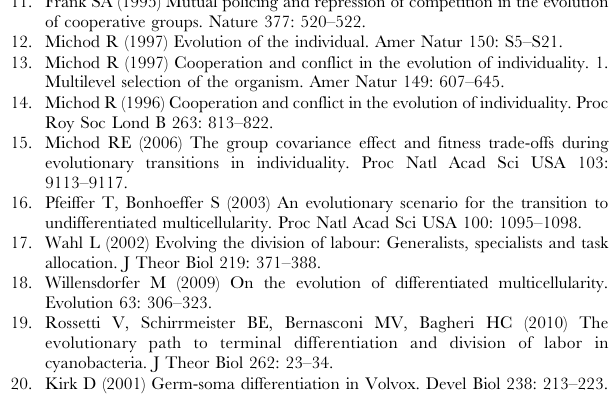
Figure S1 Numerical results for S= 16 and p= 1/4. Figure S2 Numerical results for S= 16 and p= 3/4. Figure S3 Numerical results for S= 32 and p= 1/4. Figure S4 Numerical results for S= 32 and p= 3/4. Figure S5 Numerical results for S= 64 and p= 1/4. Figure S6 Numerical results for S= 64 and p= 3/4. Figure S7 Numerical results for 1M